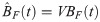
Comparison of dependent variables with and without a single dose of inhibitor.The total number of cells (B^F(t)=VBF(t), B^B(t)=ArBB(t)), inhibitors (A^F(t)=VAF(t), A^B(t)=ArAB(t)) and binding sites (E^(t)=ArE(t)) are plotted in each case. Simulations extend beyond the time span of the experiments, to 1500 hours = 62.5 days. The insets in the right-hand column show the same plots as in the larger panels, but with the y-axis spanning [0, 3 × 108]. Cases A and B: the number of bound bacteria are reduced as a result of treatment; Case C: treatment results in an increase in the number of free bacteria; Case D: treatment increases the time taken to reach a roughly equivalent steady-state to that without treatment. Eqs 1–8 were solved using ode15s. See Tables 1 and 2 for parameter values.